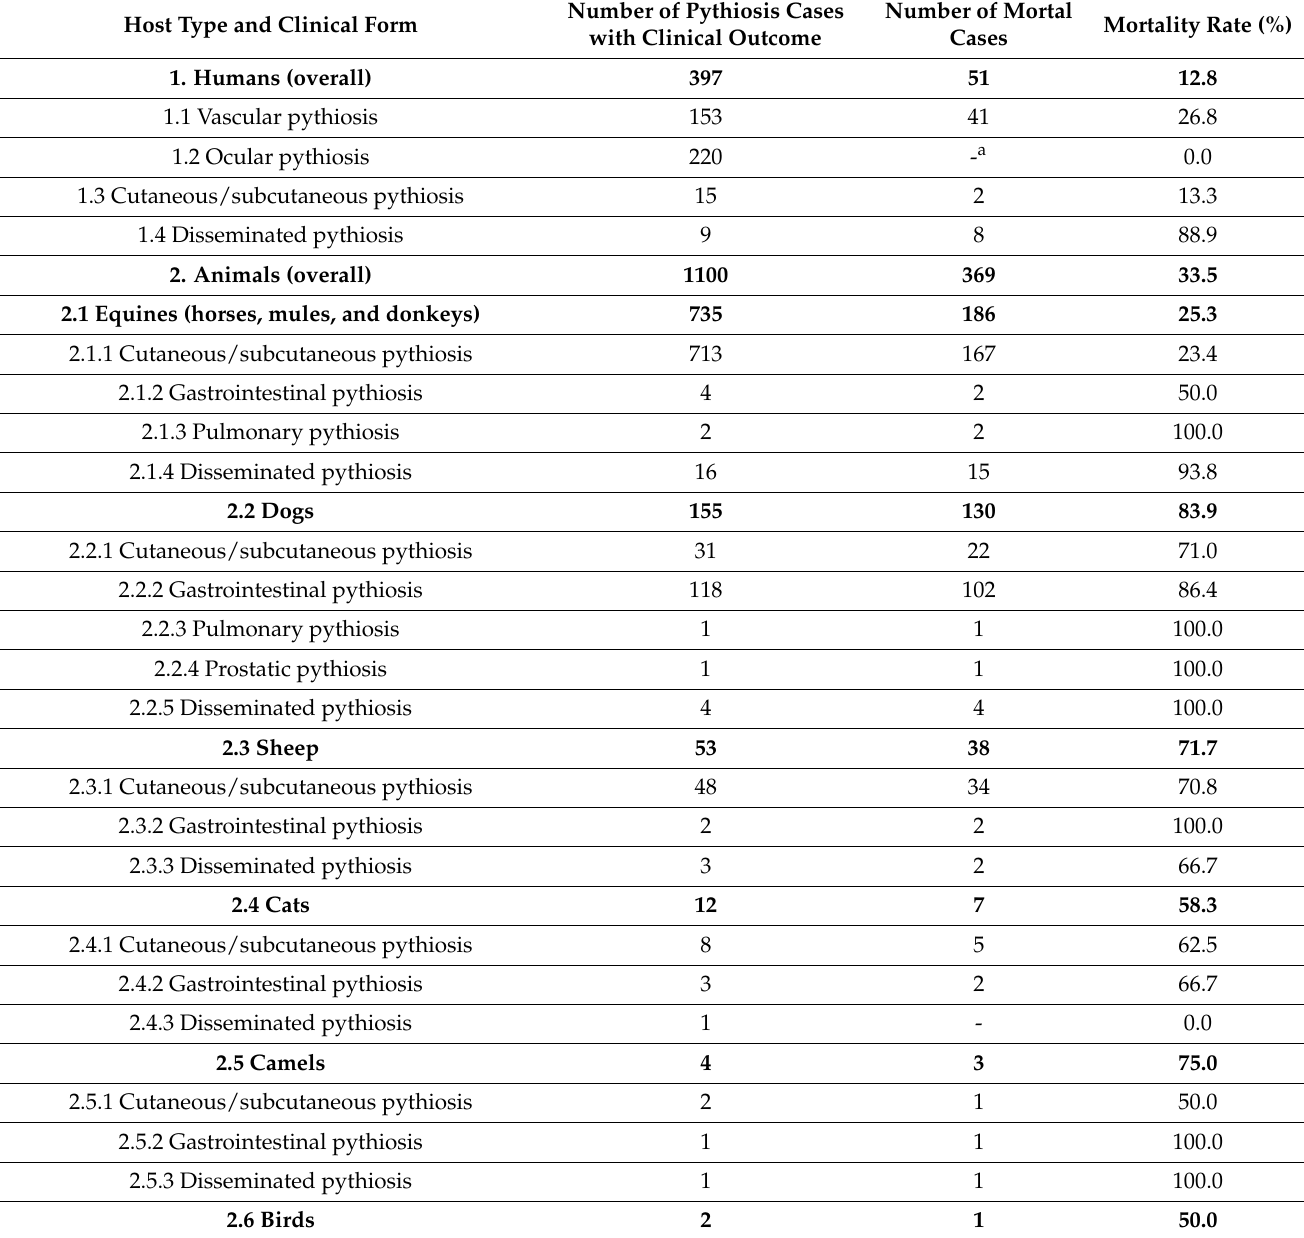
Table 4. The mortality rate of pythiosis is classified according to host types (i.e., humans and other animals) and clinical forms (i.e., vascular, ocular, cutaneous/subcutaneous, gastrointestinal, pulmonary, and disseminated